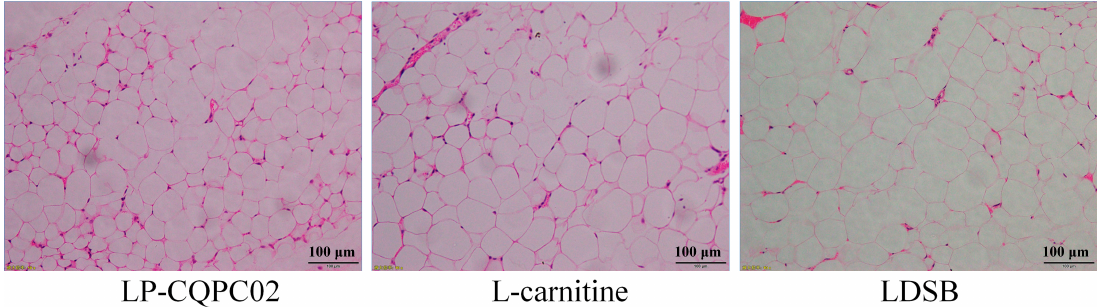
Figure 3. H&E pathological observation of epididymal tissue in mice. Magnification 100 × . LDSB: Mice treated with 1.0 × 10 9 CFU / kg of Lactobacillus delbruechii subsp. bulgaricus ; LP-CQPC02: Mice treated with 1.0 × 10 9 CFU / kg of Lactobacillus plantarum CQPC02; l -carnitine: Mice treated with 200 mg / kg of l -carnitine.